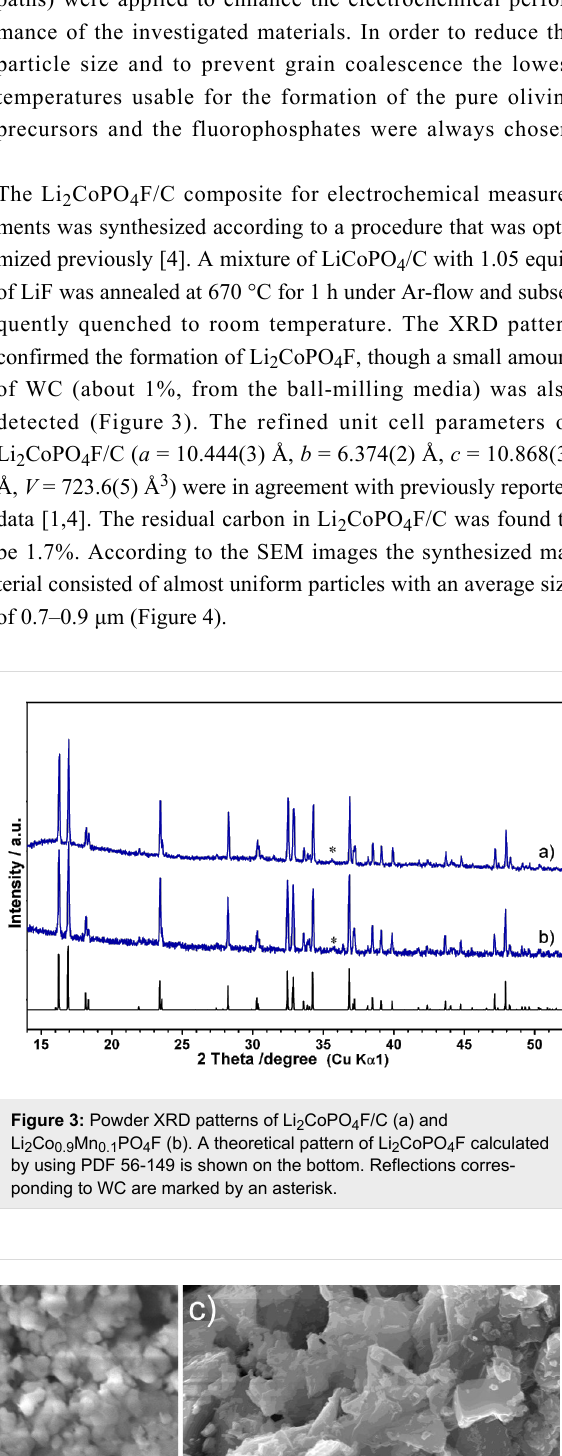
stability of 1 M LiBF 4 /TMS electrolyte up to 5.5 V, which agrees with data reported previously [12,13].